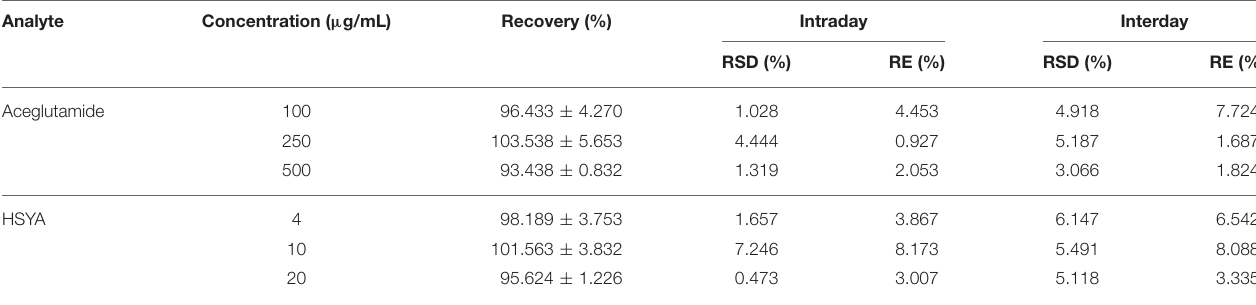
TABLE 1 | Precisions and recoveries of each reference substance ( x ± s , n = 5).